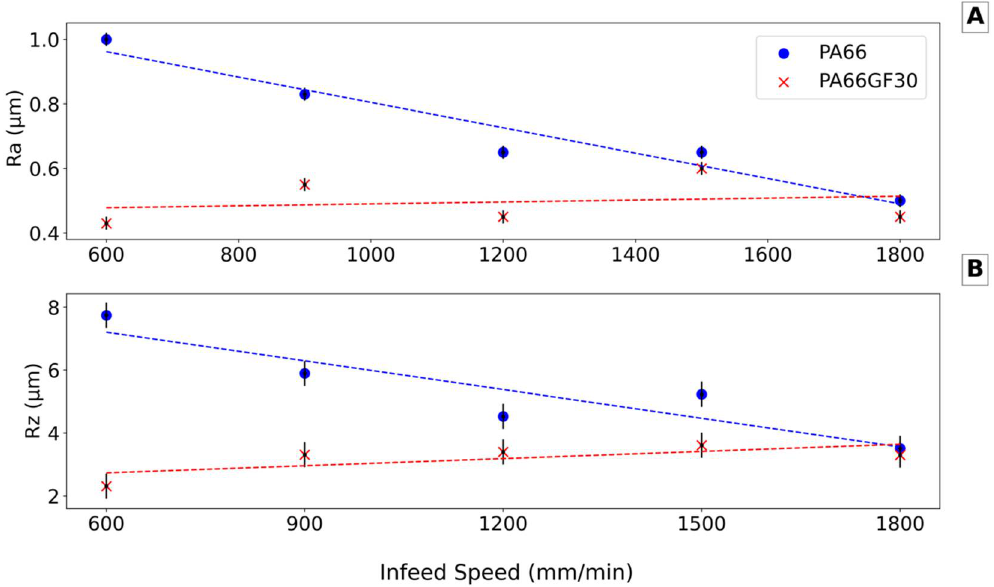
Figure 4. ( A ) The arithmetic mean height R a and ( B ) the maximum height parameter R z .